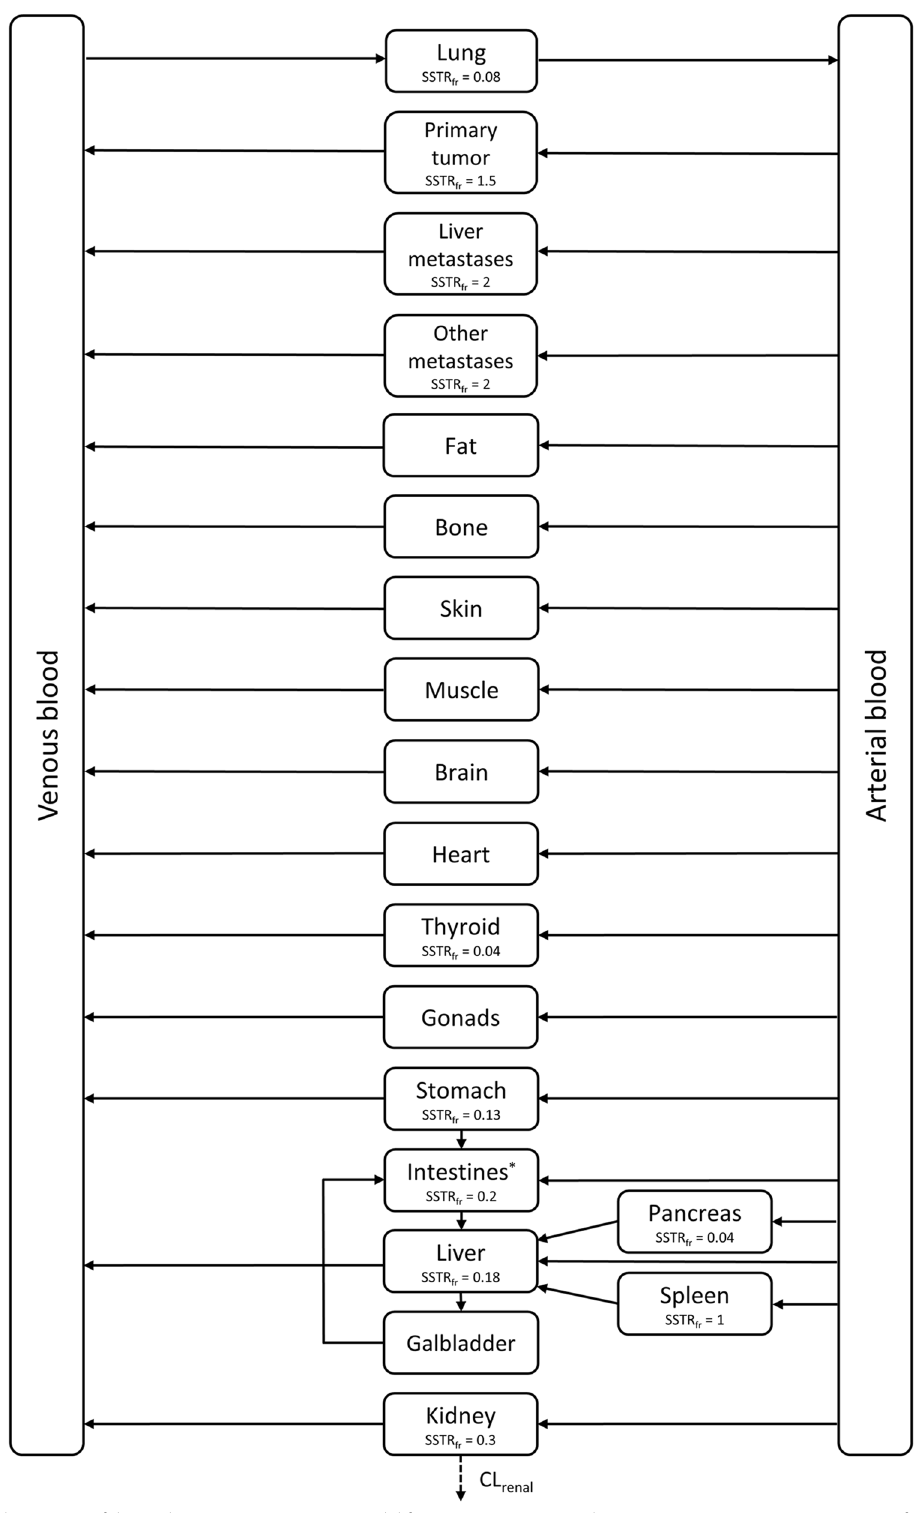
Fig. 1 Structural overview of the multi‑compartment PBPK model for GEP‑NET patients, where somatostatin receptor expression fractions (related to spleen) are depicted as SSTR fr . *Intestinal compartment consists of small intestine (SSTR2 fraction fraction 0.11). CL renal : renal clearance; SSTR fr : somatostatin receptor =